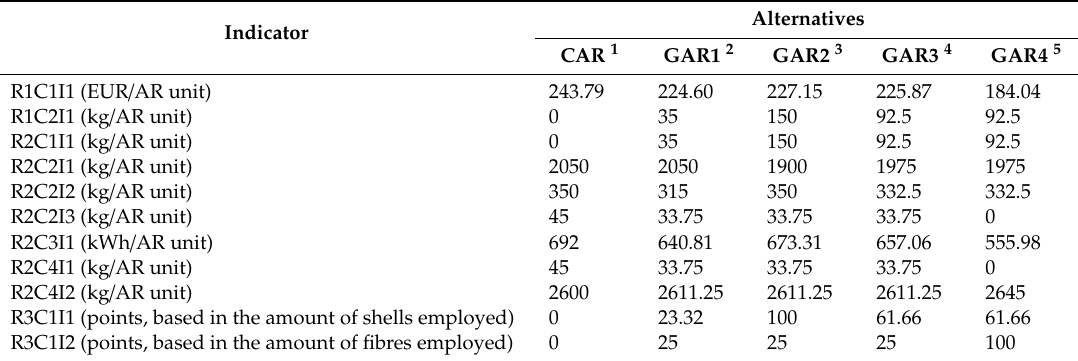
Table 10. Model input values for the di ff erent